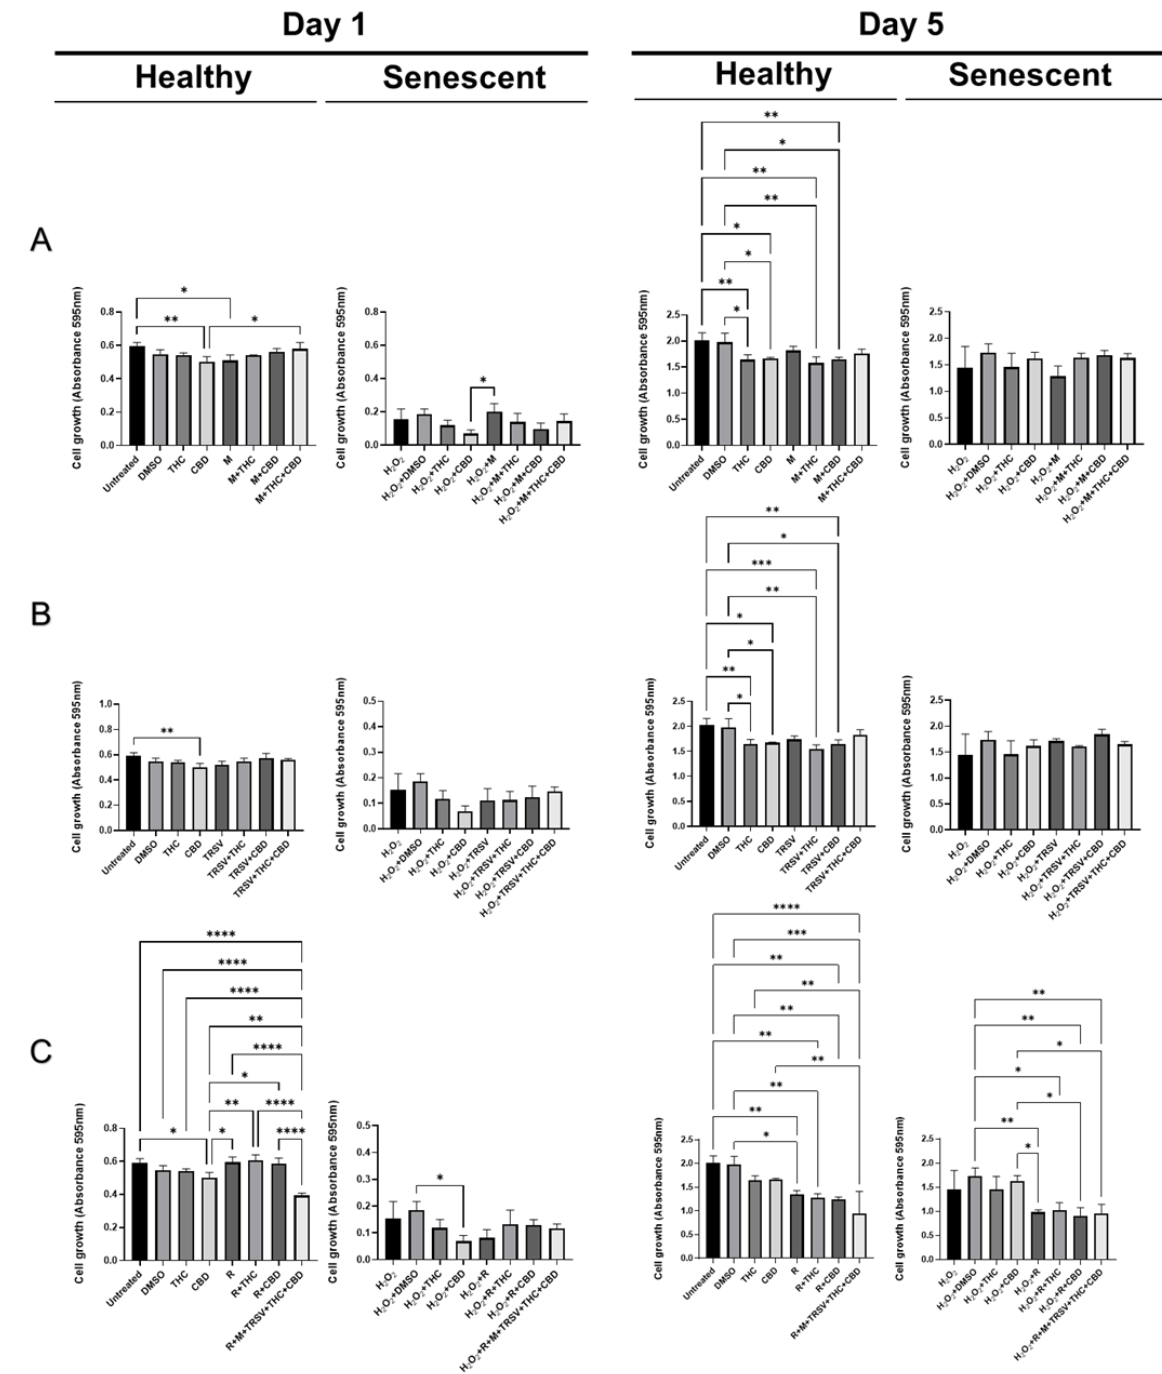
Figure 2. Viability of dermal fibroblasts CCD-1064Sk (p.11) treated with nutrient-signaling regu- lators combined with phytocannabinoids. The graphs represent cell viability of skin fibroblasts analyzed by MTT assay after experimental treatments with nutrient-signaling regulators combined with THC and CBD. Graphs show cell viability after 1 and 5 days of exposure with ( A ) metformin, ( B ) triacetylresveratrol, and ( C ) rapamycin alone or in combination with phytocannabinoids com- pared to controls and phytocannabinoids in both the healthy and senescent state. Data were analyzed with a one-way ANOVA test followed by a Tukey post hoc multiple comparison test. Bars repre- sent mean ± SD. Significance is indicated within the figures using the following scale: * p < 0.05, ** p < 0.01, *** p < 0.001, **** p < 0.0001. CBD, cannabidiol; DMSO, dimethyl sulfoxide (vehicle), M, metformin; R, rapamycin; THC, ∆ -9-tetrahydrocannabinol; TRSV,